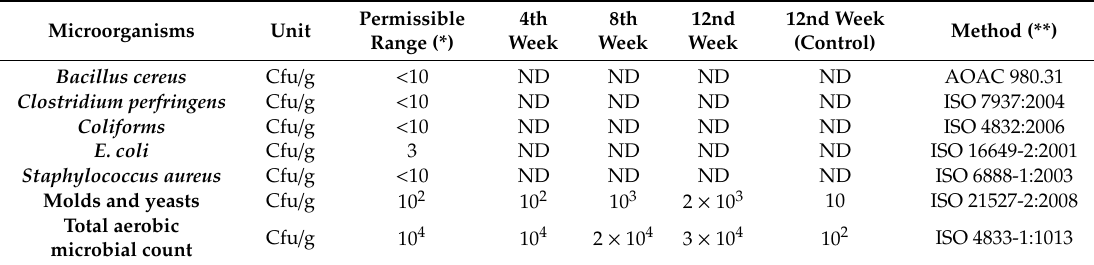
Table 5. Microbiological testing results of sponge cake after storage